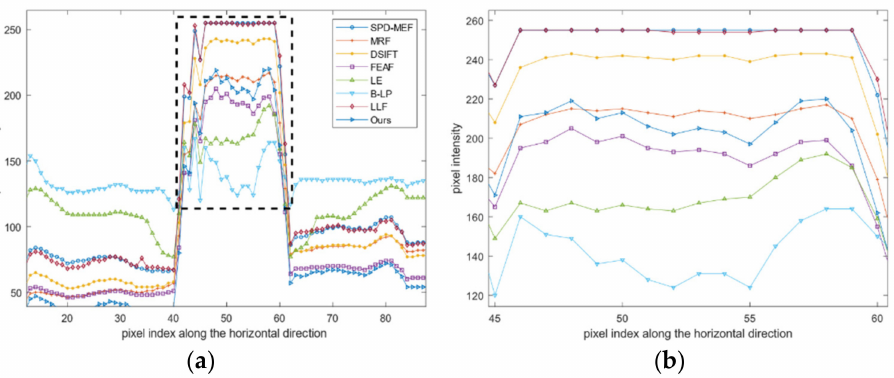
Figure 14. Pixel intensity analysis of the zoom-in patches in Figure 10 along the horizontal direction. ( a ) Comparison of eight methods. ( b ) Enlarged image of the data in the black box in ( a